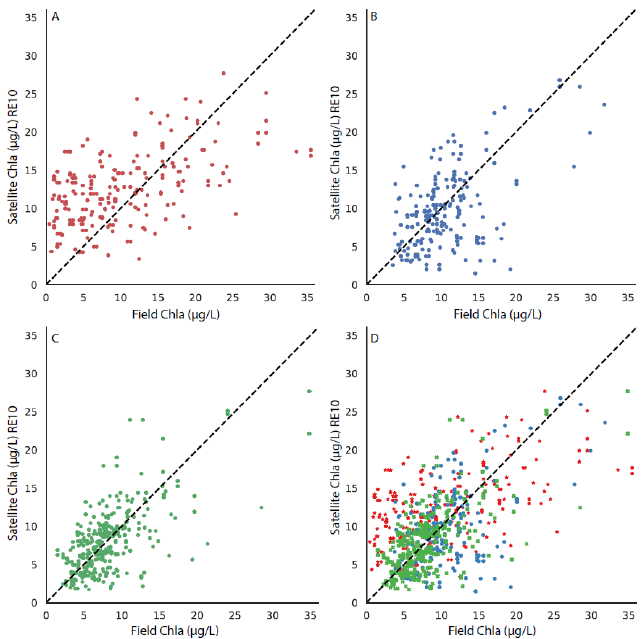
Figure 2. The matchup between the field chla and the OLCI-RE10 algorithm, with the 1:1 line shown in each subplot for stations in ( A ) the upper bay, ( B ) the middle bay, ( C ) the lower bay, and ( D ) all stations, with the upper, middle, and lower bays differentiated by symbol color and style.